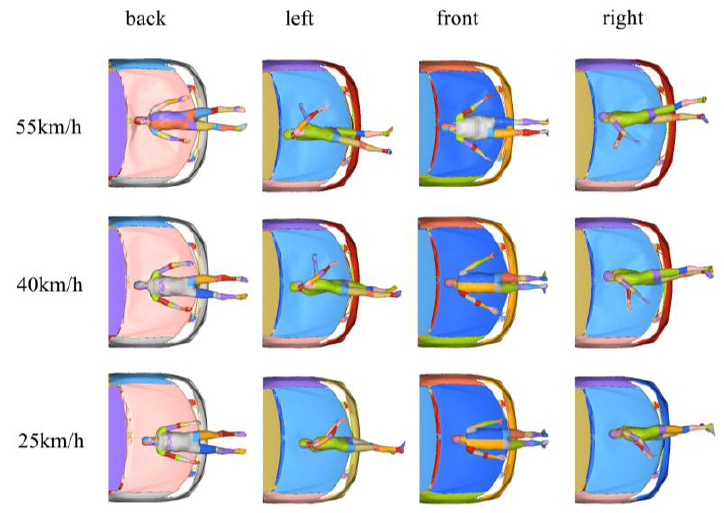
Figure 4. Head impact points at different collision parameters.